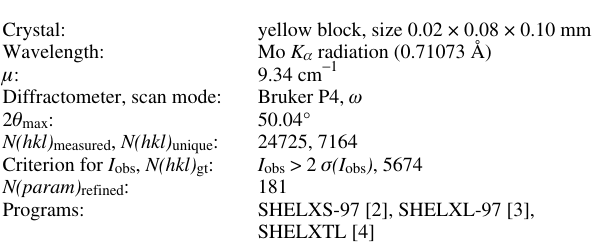
Table 1. Data collection and handling.